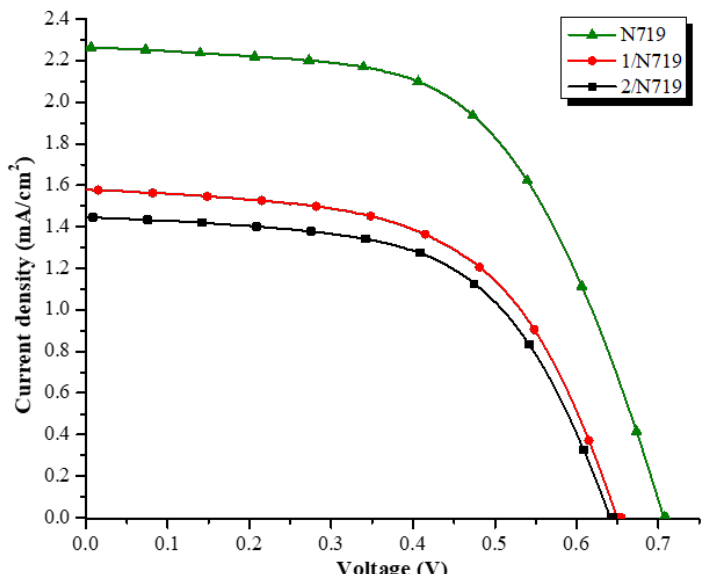
Figure 6. J – V curves for DSSCs of 1 and 2 based on co–sensitized photoelectrodes with N719 in